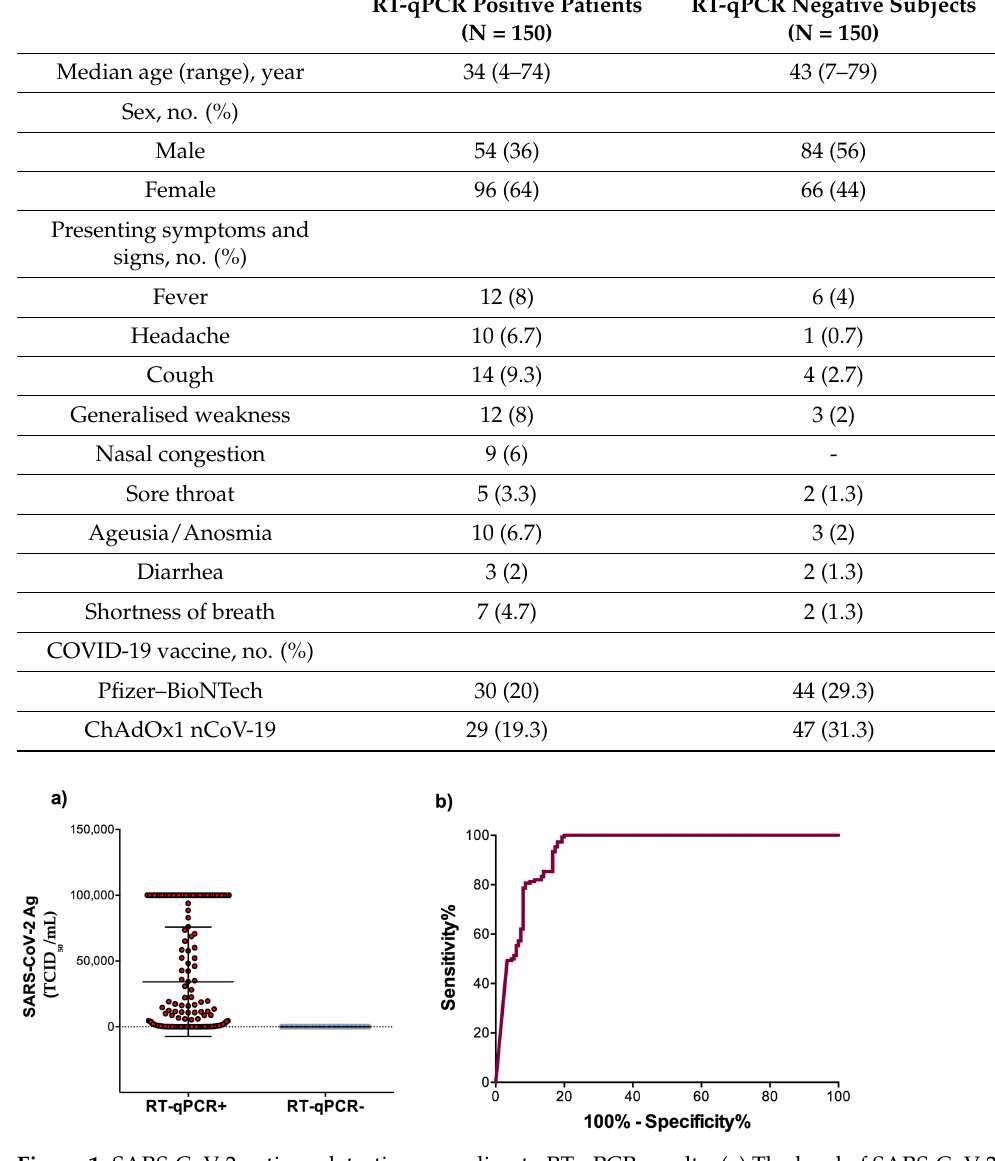
Figure 1. SARS-CoV-2 antigen detection according to RT-qPCR results. ( a ) The level of SARS-CoV-2 Ag among the RT-qPCR positive and negative samples. ( b ) Receiver operating characteristic (ROC) curve analysis to evaluate the diagnostic value of the LIAISON SARS-CoV-2 Ag assay. Data are presented as mean ± SD. Table 2. Assessment of the diagnostic accuracy of the automated LIAISON ® SARS-CoV-2 antigen test in nasopharyngeal